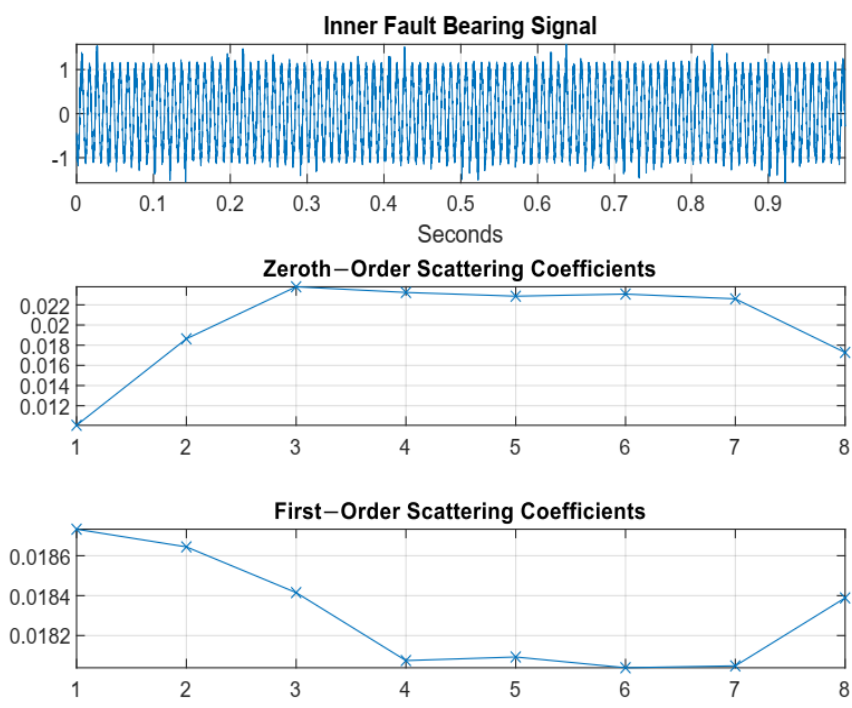
Figure 8. Time series bearing data, 0th and 1st order scattering coefficients of the inner race faulty conditions.